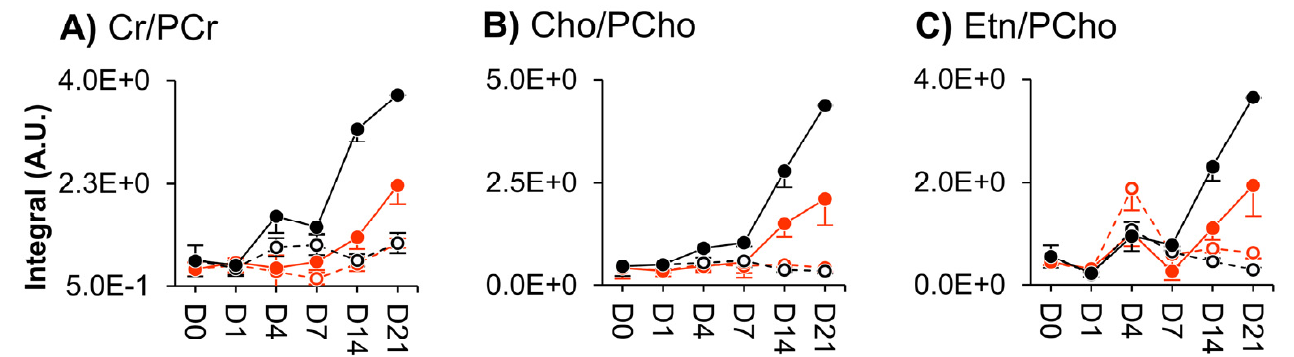
Figure 4. Metabolic ratios as donor-independent markers specific to hAMSCs osteodifferentiation (solid lines) in comparison with their control counterparts (dashed lines); ( A ) Cr/PCr, ( B ) Cho/PCho and ( C ) Etn/PCho for donors 1 (in black) and 2 (in red).